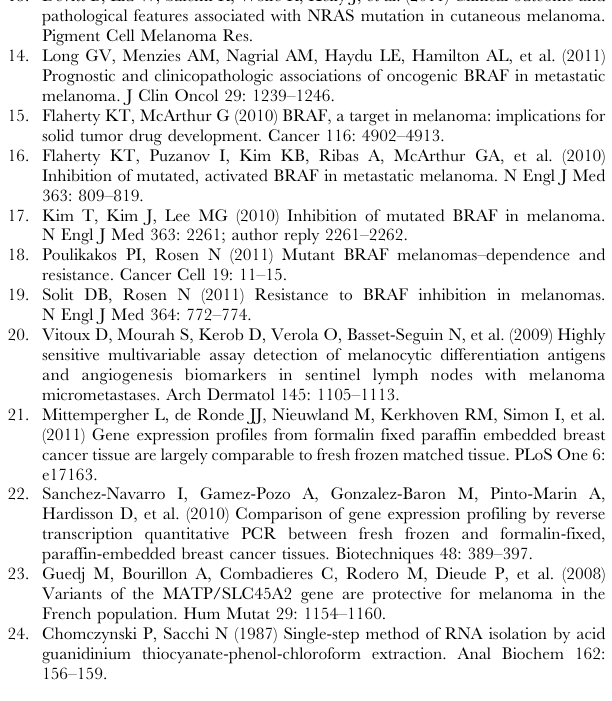
Figure S1 Classification approach: supplementary method